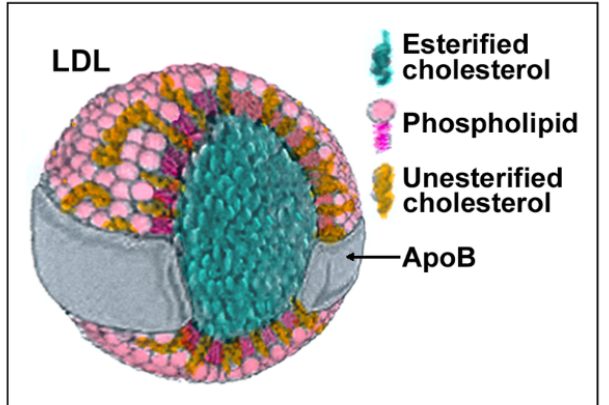
Figure 1. Structure and composition of LDL. Each component of LDLs can be modified by oxidation generating molecules such as oxysterols, oxidized phospholipids, 4-hydroxynonenal (HNE), malondialdehyde (MDA), and modified apoB.